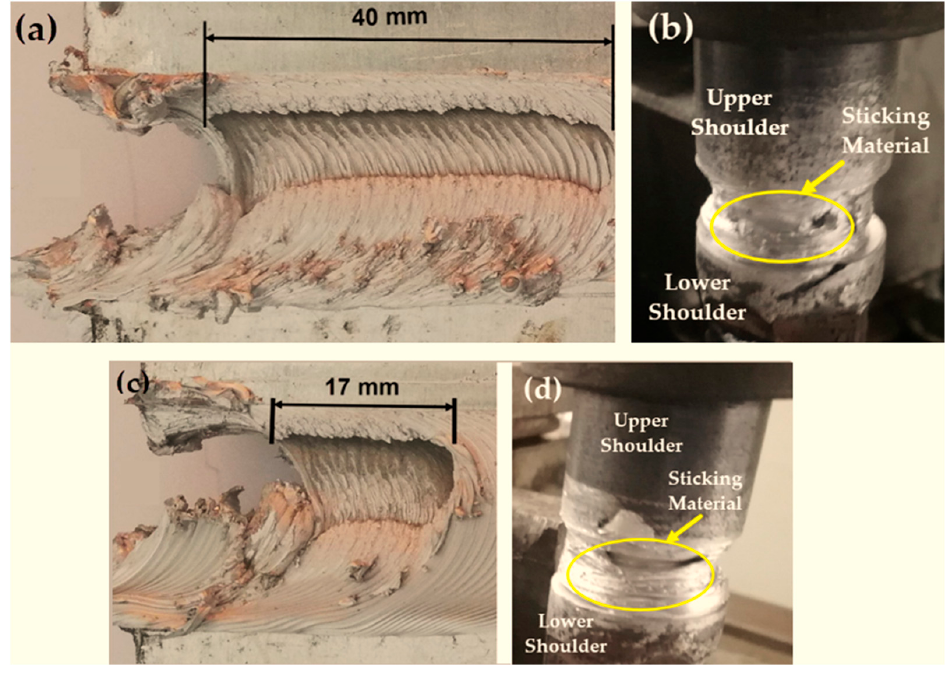
Figure 14. BT-FSW uncompleted joining defect and stick material around the BT using Tr pin at ( a and b ) 800 mm/min, ( c and d ) 1000 mm/min .